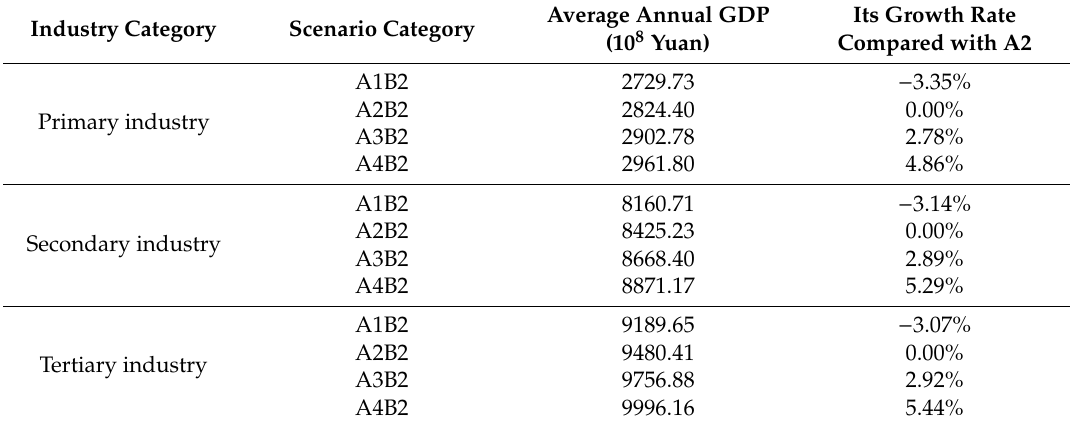
Table 7. Average annual output value of various industries and its growth rate compared with A2 under